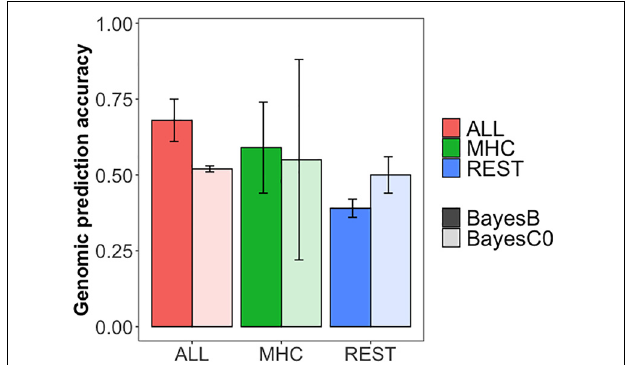
FIGURE 3 | Genomic prediction accuracies for antibody response [sample-to-positive (S/P) ratio] to porcine reproductive and respiratory syndrome virus vaccination. The colors indicate the set of single-nucleotide polymorphisms (SNPs) used in the analysis: whole dataset (ALL, coral), only the SNPs in the major histocompatibility complex region (chromosome 7, 23, to 26 Mb; MHC, green), and only SNPs outside the MHC region (REST, blue). The transparency indicates the method of estimation used: darker colors represent BayesB analysis (Pi = 0.995), and lighter colors represent BayesC0. Error bars represent the standard deviation across three cross-validation